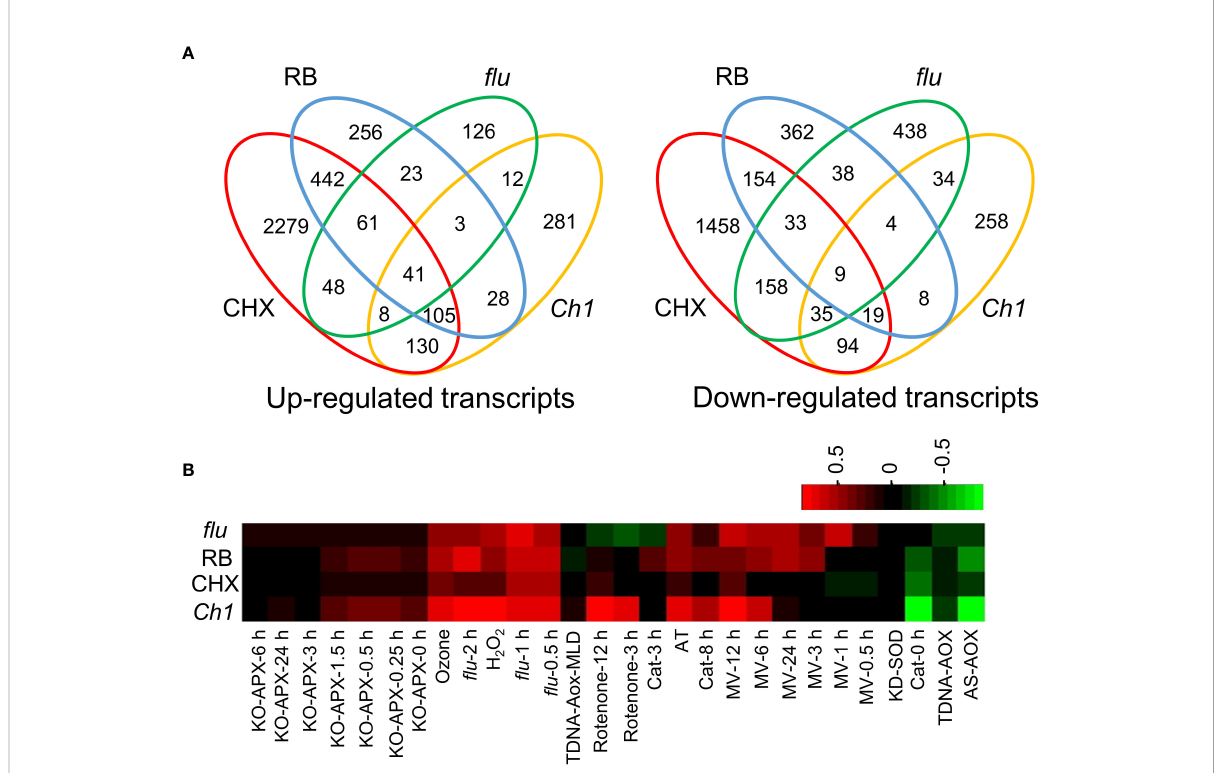
FIGURE 1 Comparison of transcriptomes of seedlings treated by RB, DCMU, cycloheximide (CHX) and from the fl u mutant. Arabidopsis seedlings were treated with either CHX (100 µM, 2 h, 30 µE m -2 s -1 ) or RB (400 µM, 2 h, 30 µE m -2 s -1 ). The fl u mutant was incubated in the dark for 4 h, before light exposure (30 µE m -2 s -1 ) for 30 min. The Ch1 transcriptome was treated under HL/cold conditions (1200 µE m -2 s -1 , 10°C, 48 h, see Ramel, 2013) Further details and the source of transcriptomes are referenced in the Methods. (A) Venn diagram overlaps of 2-fold induced genes of Up-regulated (left) and Down-regulated genes (right). (B) ROSMETER transcriptomic analysis. Transcriptomes of all signi fi cant up and down- regulated genes were analysed using the ROSMETER tool showing the correlation of gene activity with the ROSMETER databases. Red represents a positive correlation of +1, and green represents a negative correlation of